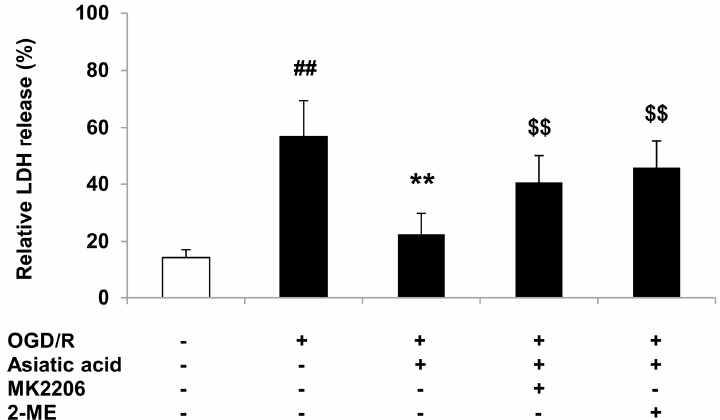
Figure 5. Inhibition of Akt or HIF-1 α attenuates the protective effects of asiatic acid in OGD/R-injured H9c2 cells by LDH release assay. ## p < 0.01 vs. the vehicle group; ** p < 0.01 vs. the OGD/R group; $$ p < 0.01 vs. the asiatic acid-treated group.